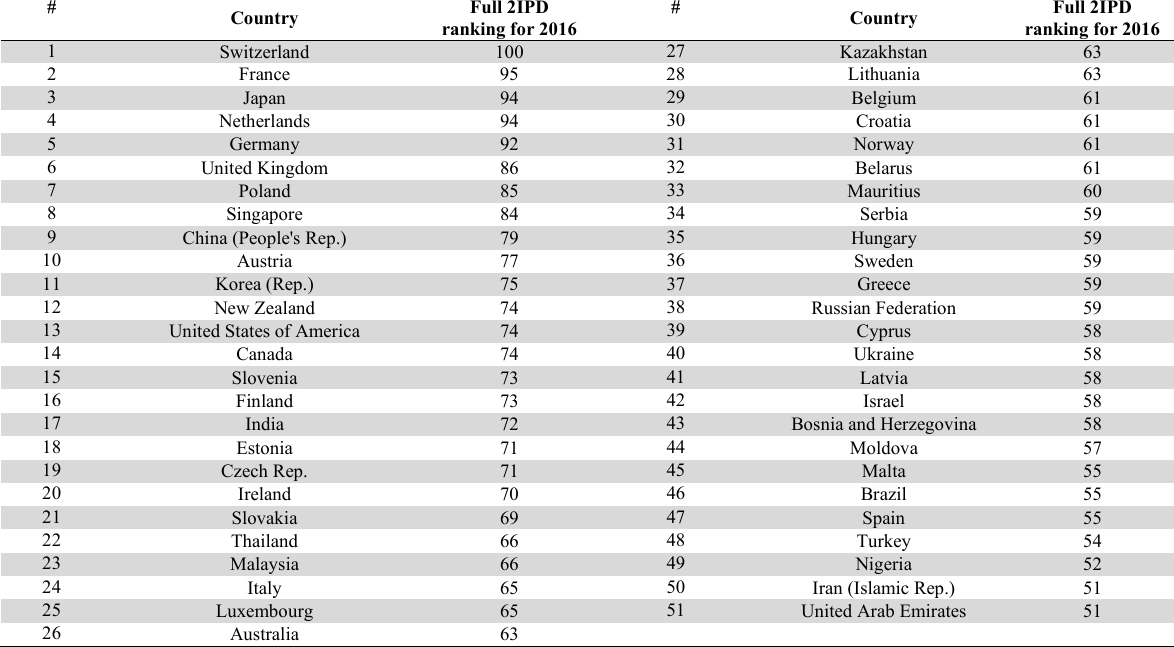
Ranking of the world first 51 countries on the global average indicator of the mail business development # Full 2IPD Country ranking for